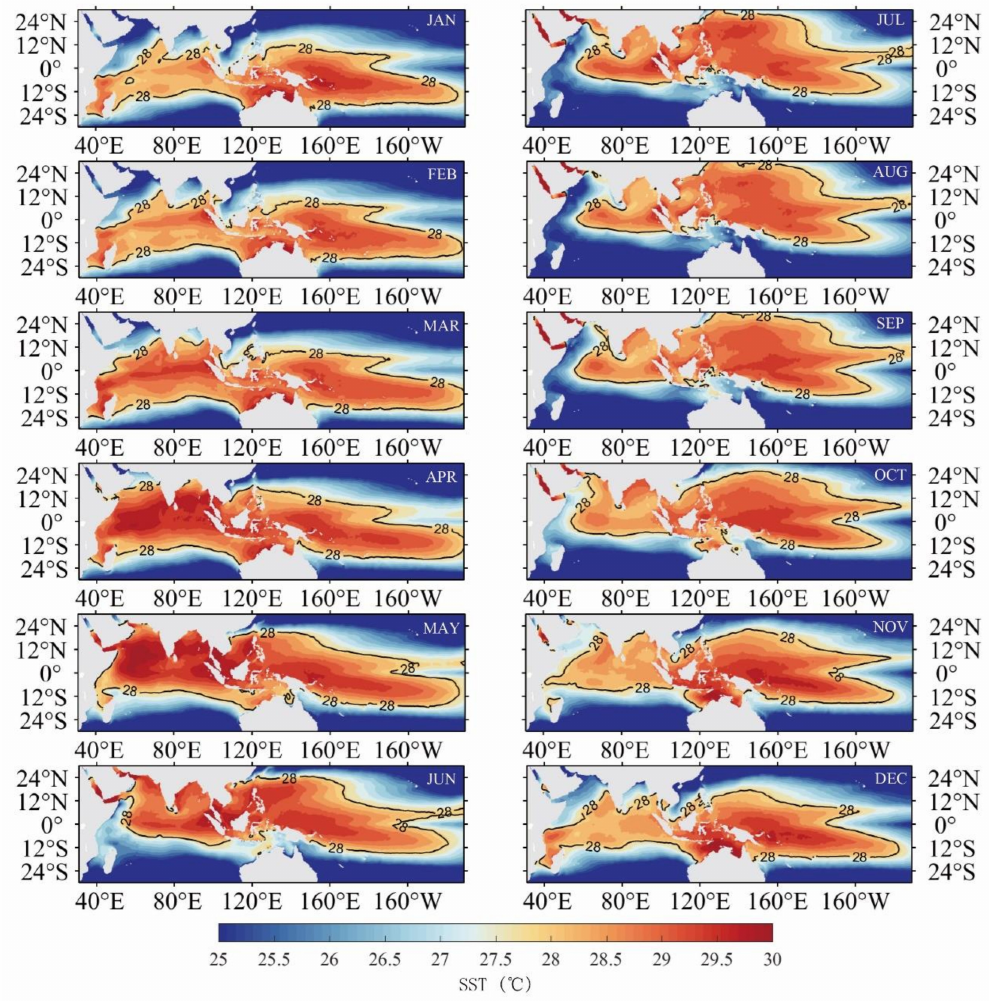
Figure 2. SST monthly climatology of the IPWP.